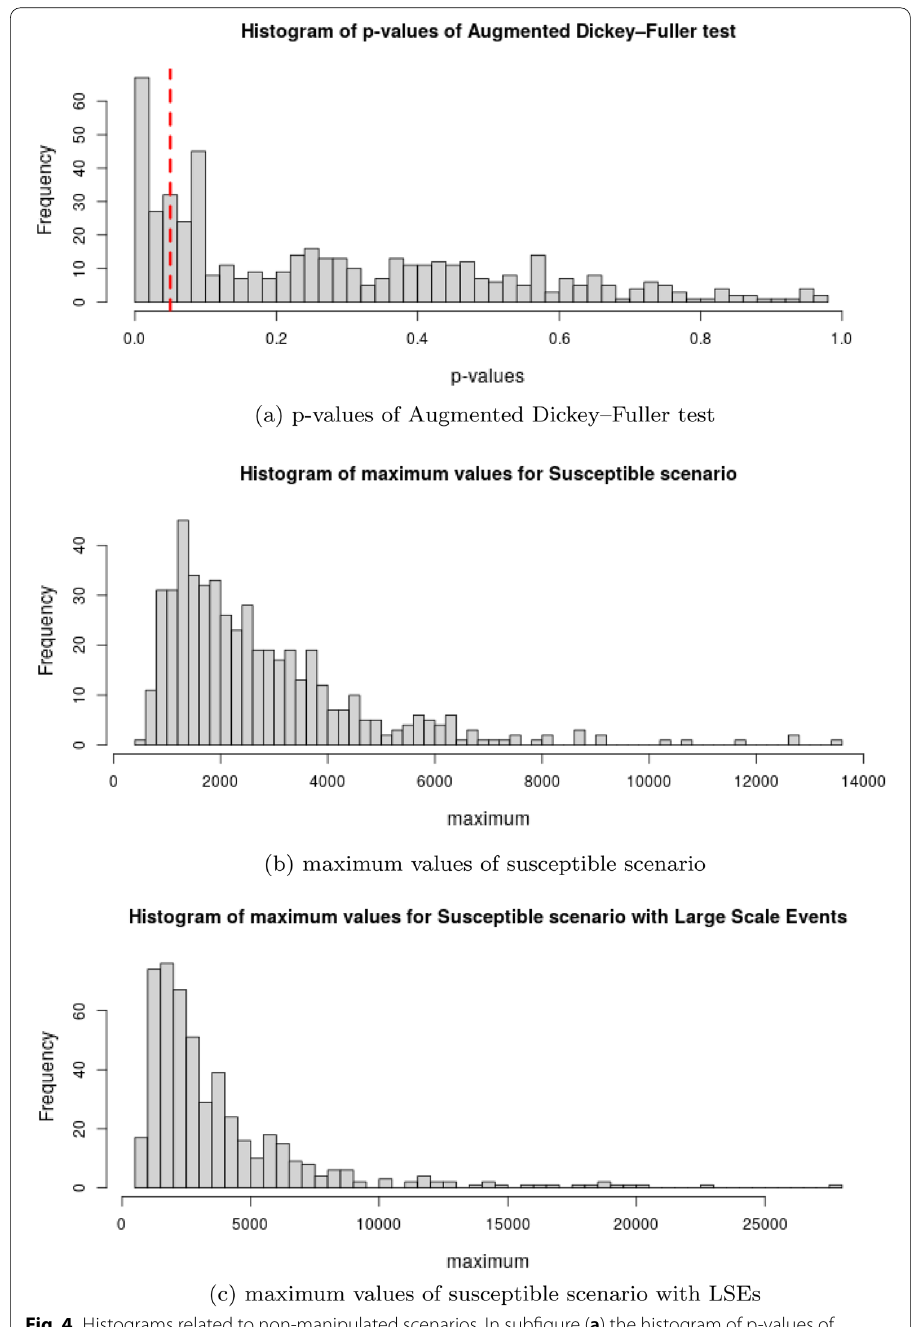
Fig. 4 Histograms related to non-manipulated scenarios. In subfigure ( a ) the histogram of p-values of Augmented Dickey-Fuller test calculated for each simulation of the base scenario is plotted with a red dashed line at value 0.05. In subfigures ( b ) and ( c ) the histograms of maximum values of the market price achieved during each simulation are plotted for susceptible scenario and susceptible scenario with LSEs,